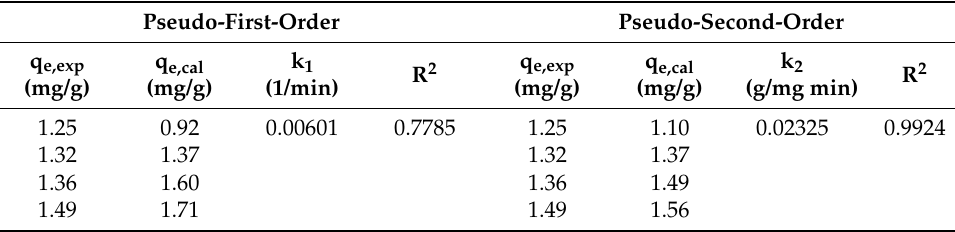
Table 3. Kinetic parameters of phosphorus adsorption onto HAOPs.